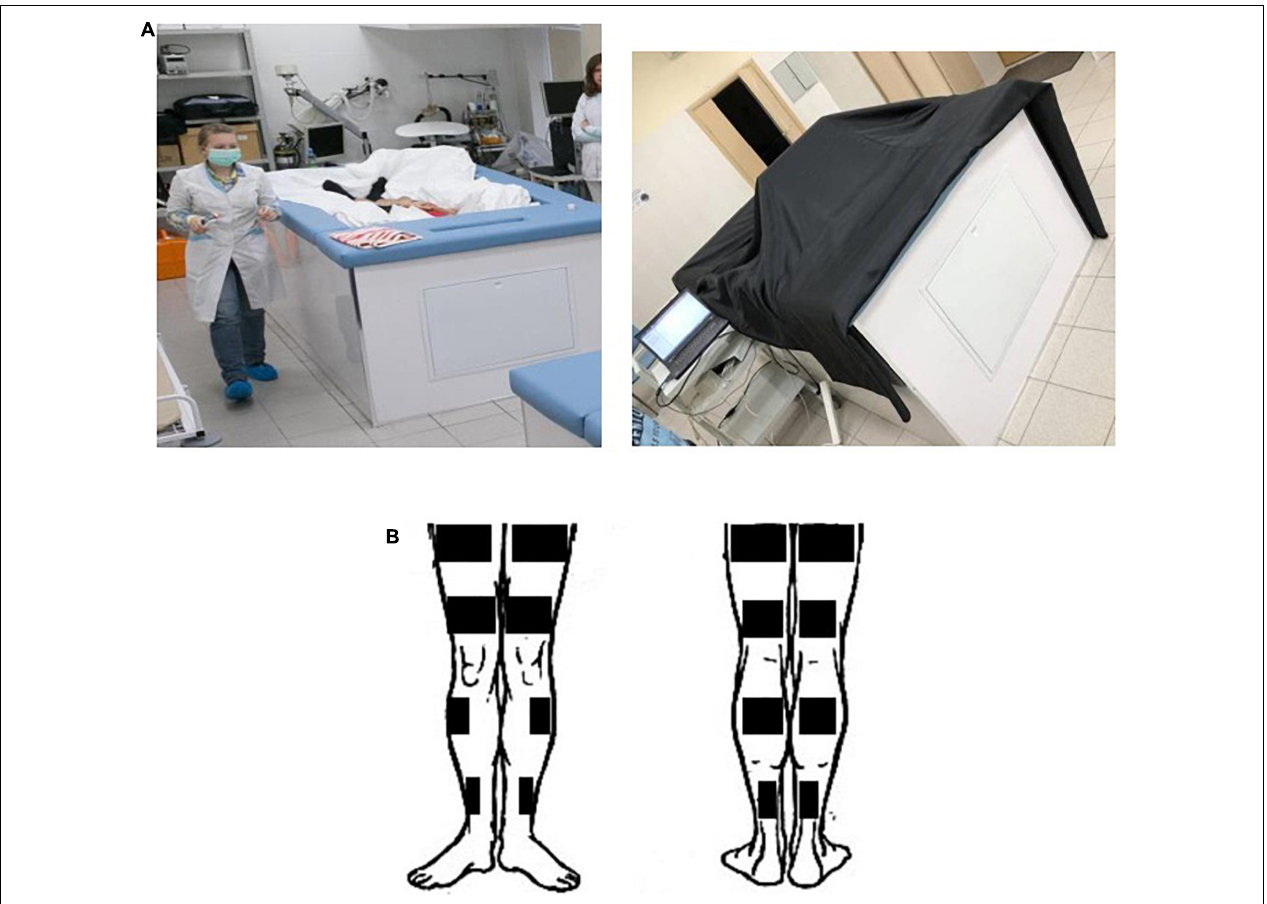
FIGURE 1 | Conditions of “dry” immersion experiment. (A) The demonstration of conditions in the DI experiment to assess the contrast sensitivity. (B) A scheme of electrode positioning for the